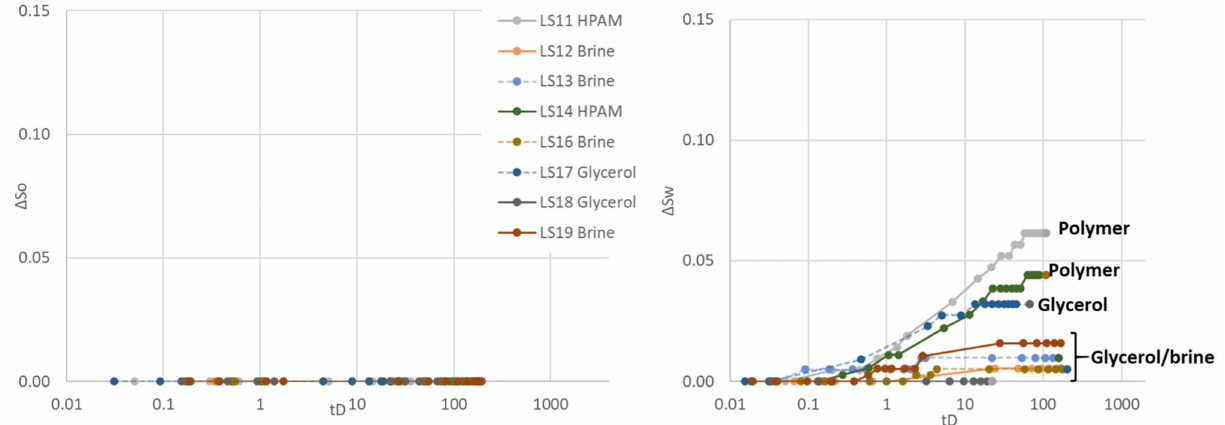
Figure 7. Oil ( left ) and water ( right ) saturation change as a function of dimensionless time during the fifth Amott–Harvey cycle. Note that LS11 and LS14 were placed in Amott cells filled with polymer or glycerol for spontaneous imbibition, and were also forcedly flooded with polymer/glycerol. After flooding, however, brine was injected to displace the high viscous aqueous phase and oil imbibition were performed in water-filled cores. Note that the y -axis only represents a part of the mobile saturation range. The scale is kept constant for all cycles, to enable simple comparison of